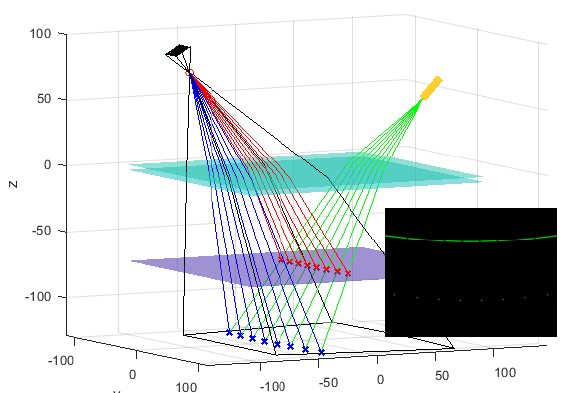
Figure 4: Calibration set-up. 3D-scheme and camera image. Sub-beams (green) are measured in two levels (red and blue crosses). The top level (purple plane) is designed as a grid. The image captured by the camera is shown in the small image.